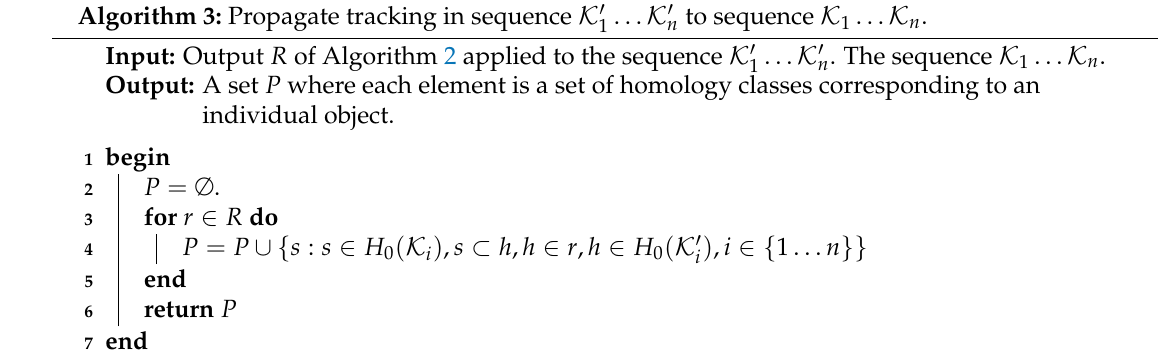
. . . K (cid:48) to sequence K 1 . . . K n n 1